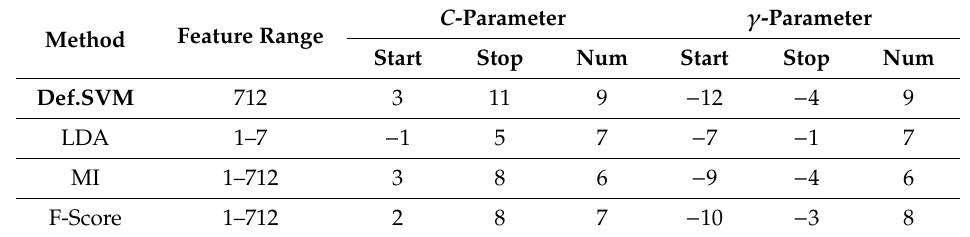
Table 7. Parameter grid for the exhaustive grid search (Beijing).